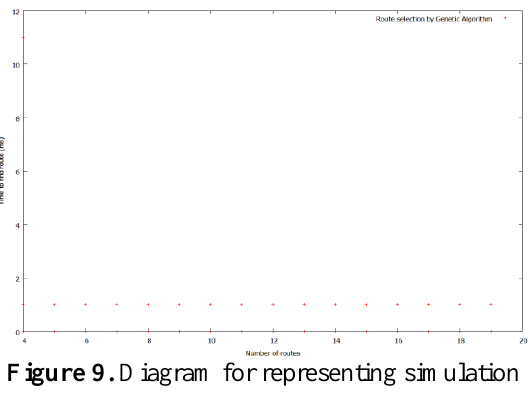
Figure 9. Diagram for representing simulation results of GA to find optimal route.